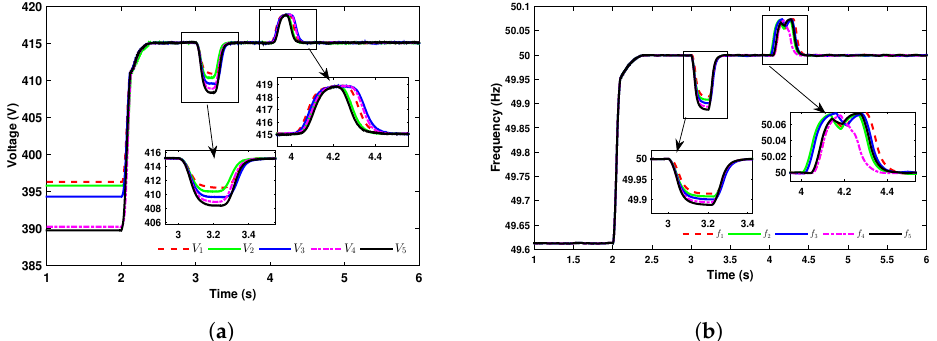
Figure 6. Convergence performance of the proposed restoration algorithm. ( a ) Voltage. ( b )